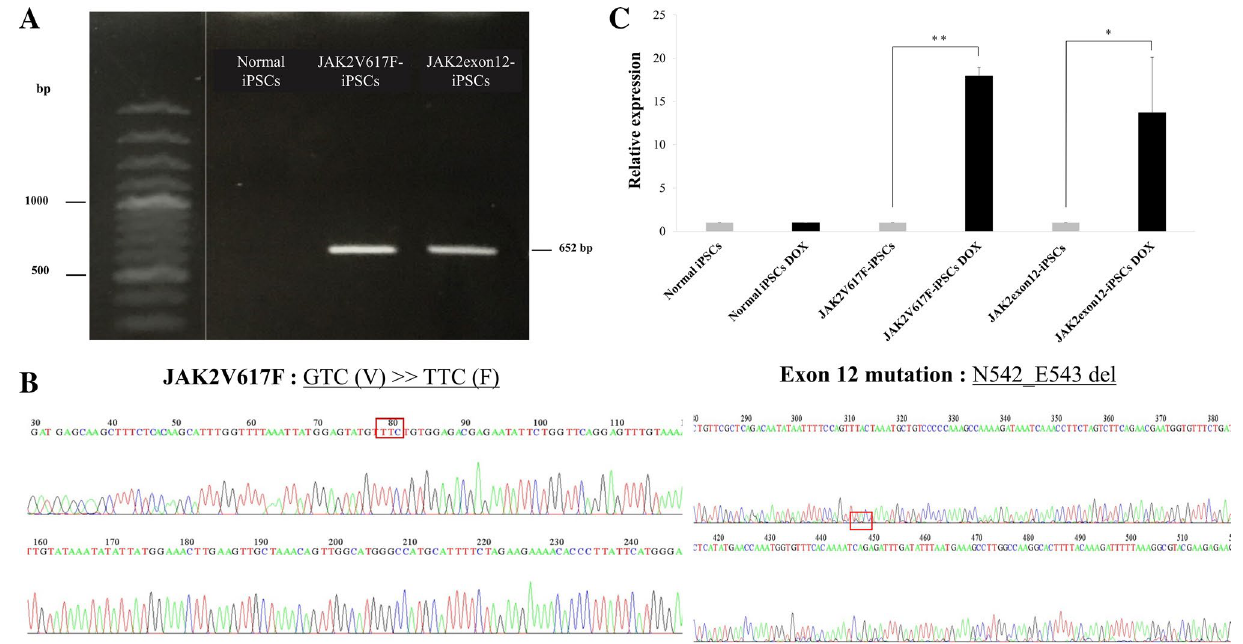
Figure 1. Verification of JAK2 gene mutations and expression in the modified induced pluripotent stem cells (iPSCs). ( A ) Conventional polymerase chain reaction (PCR) using transgene-specific primers showed exogenous JAK2 genes in the two modified iPSC lines. The normal iPSC line was used as a negative control. The full gel is presented in the Supplementary Fig. S1A. ( B ) DNA sequencing confirmed the point mutation p.V617F in exon 14 and the p.N542_E543del in exon 12 of JAK2 gene in the respective iPSC lines. ( C ) Exogenous JAK2 gene expression levels in iPSCs after transfection comparing normal, JAK2V617F and JAK2 exon 12 mutation with and without doxycycline (DOX) induction for 24 h and analyzed by real-time quantitative RT-PCR. Data are presented as means ± standard deviations (SD) from three independent experiments. The asterisks (*) and (**) denoted p < 0.05 and p <